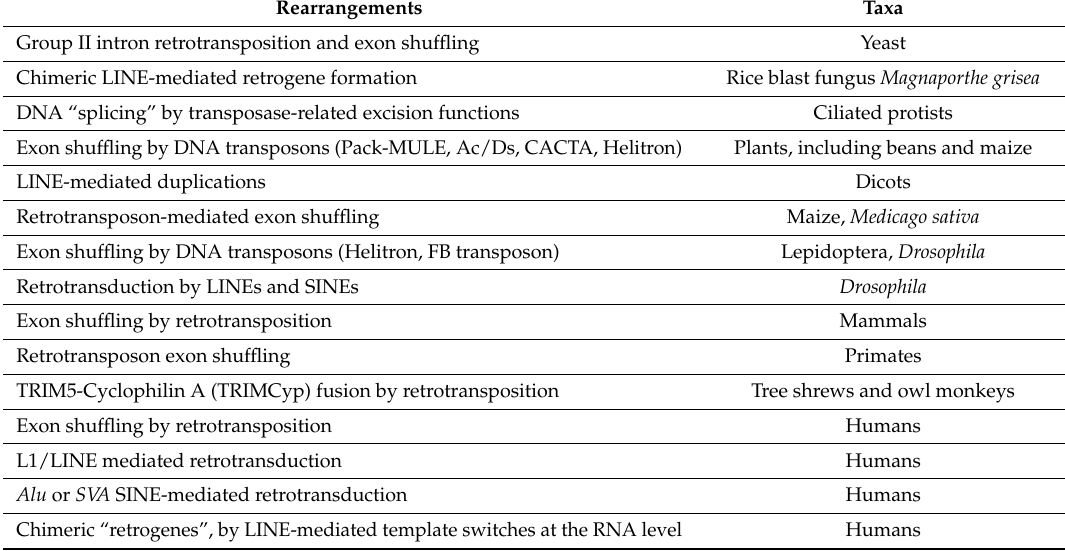
Table 9. Selected Reports of Exon Rearrangements and Retroposition by Mobile DNA element